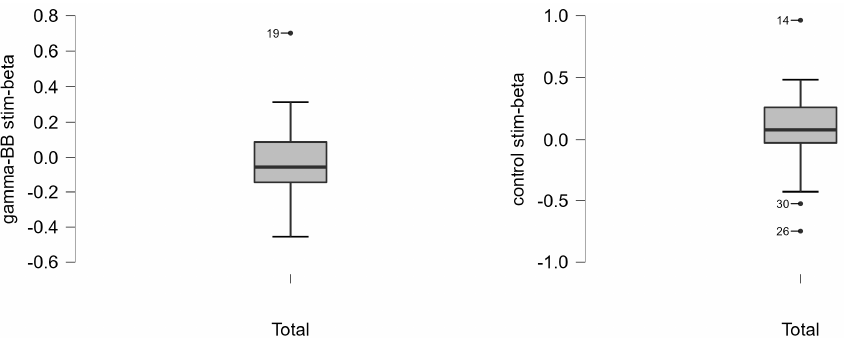
Figure 7. Boxplot of 1st component in resting state in beta frequency with outliers labeled for gamma-BB and control stim.